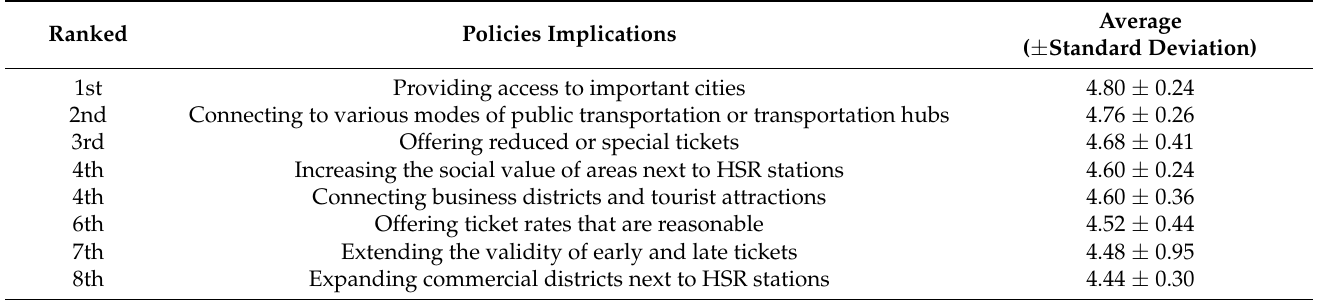
Table 5. An overview of railway experts’ feedback regarding policy